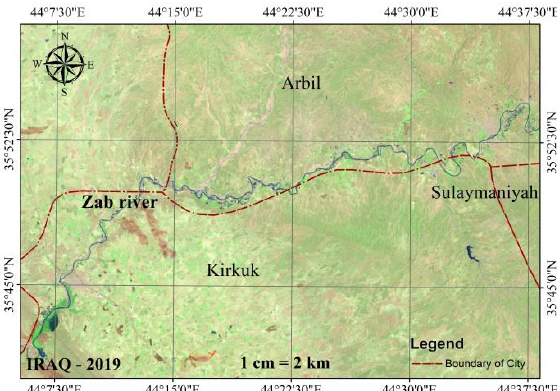
Figure 1. The path of the Zab River within the study